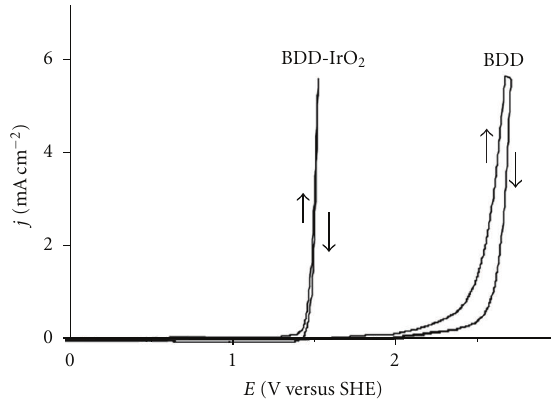
Figure 3: Cyclic voltammograms recorded at BDD and BDD- IrO 2 ( G = 6 . 4) electrodes in 0.5M H 2 SO 4 . Scan rate: 100 mVs − 1 . Geometric surface area 1cm 2 . G = 1 corresponds to 10 15 molecules IrO 2 cm − 2 (reprinted with permission from